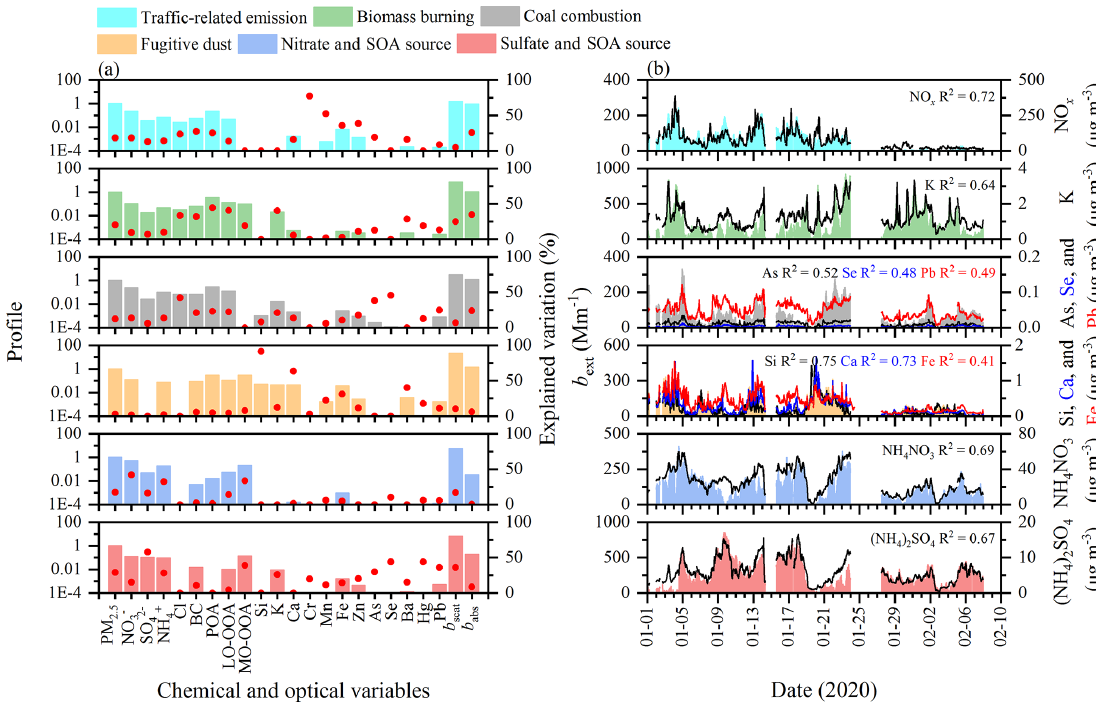
Figure 5. (a) Profiles and (b) time series plots of the resolved source factors in the six-factor solution, including traffic-related emissions, biomass burning, coal combustion, fugitive dust, the nitrate and SOA source, and the sulfate and SOA source. The columns in each factor are the profile that displays the relative relation of the absolute values of variables. The red dot represents the explained variation in species for different factors. The corresponding time trends of chemical tracers are also shown.